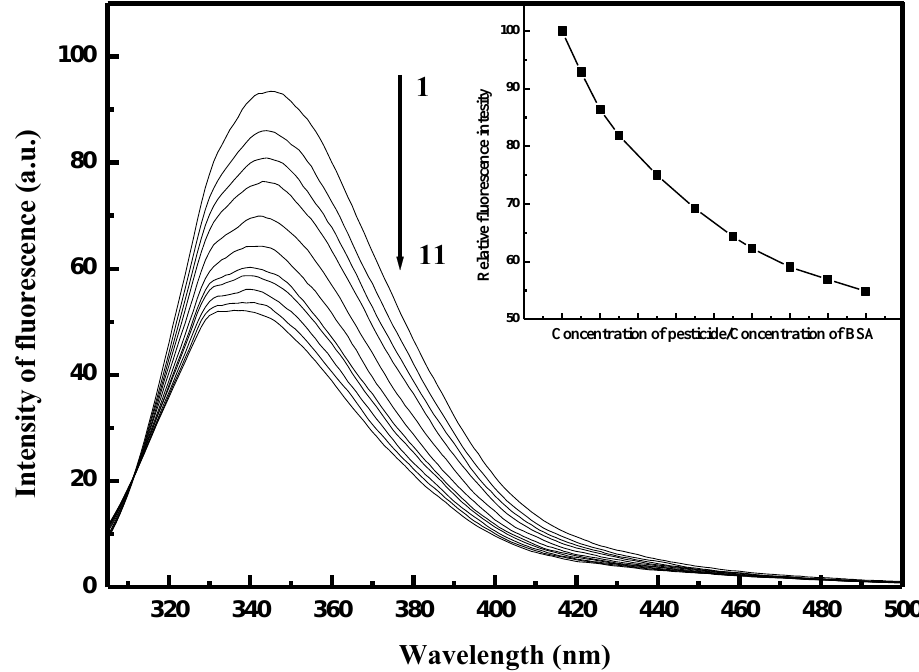
Figure 3. Quenching of bovine serum albumin (BSA) fluorescence after prothioconizole (PTC) binding. c (BSA) = 2 × 10 − 6 mol/L; c (PTC) = 2 × 10 − 6 mol/L–32 × 10 − 6 mol/L (1–11). Inset: Decrease in BSA fluorescence in the presence of PTC.